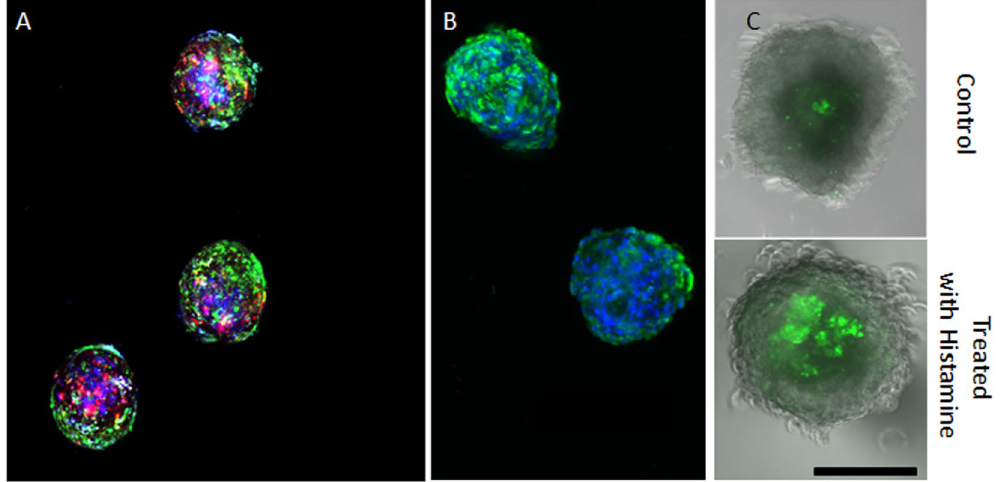
Figure 1. Assessment of cell localization, tight junction protein expression, and barrier properties in self- assembled spheroids. Spheroids in ( A ) show self organisation of endothelial cells and pericytes to the outermost sphere whereas the astrocytes and neurons (violet) are encapsulated by the endothelial cells and pericytes. ( B ) Spheroids containing HBMEC, astrocytes, and pericytes were formed through self assembly. Shown is ZO-1, a tight junction protein that prevents free paracellular transport of molecules across the vascular-type barrier. Dapi (blue) shows nuclear staining. Also shown in the figure are empty pockets where there is no ZO-1, this indicates that the HBMECs are likely not completely covering the spheroid. ( C ) Permeability assessment was done through incubating the spheroids containing HBMEC, pericytes and astrocytes with FITC labeled IgG. The upper panel represents spheroids with an uncompromised vascular-type barrier (control) and the lower panel shows spheroids that were treated with histamine to transiently open the vascular-type barrier. Scale bar, 300 μ